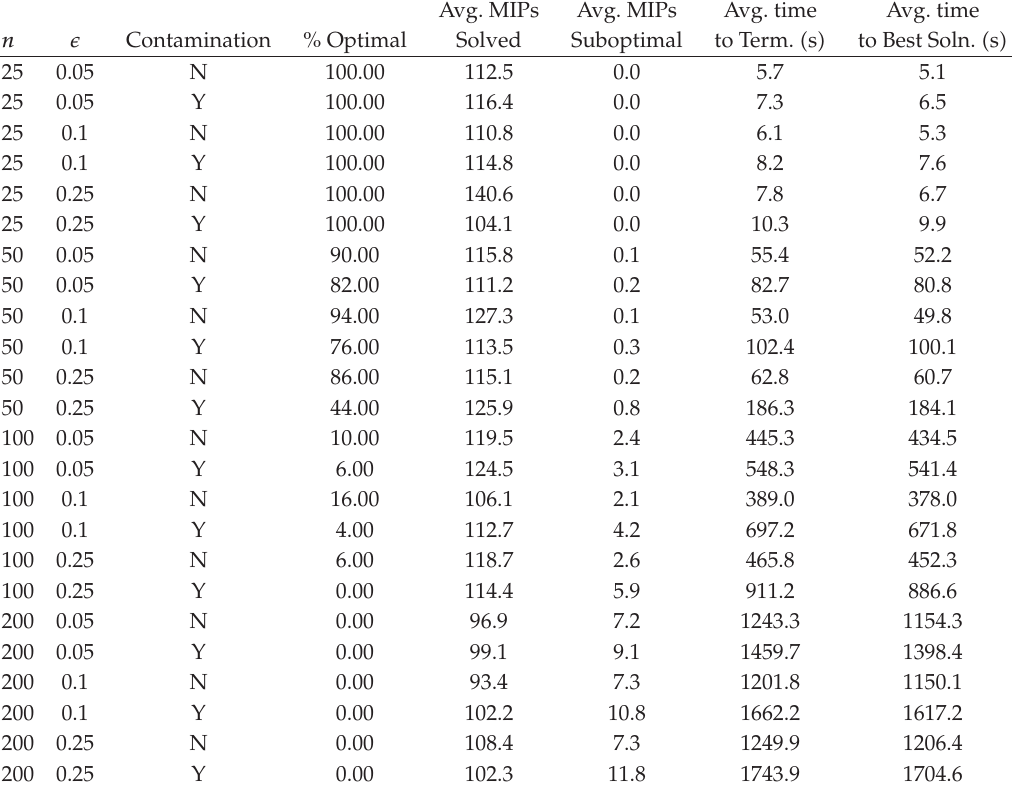
Table 6: Computational performance of L 1 OR implementation for simulation with clustered leverage